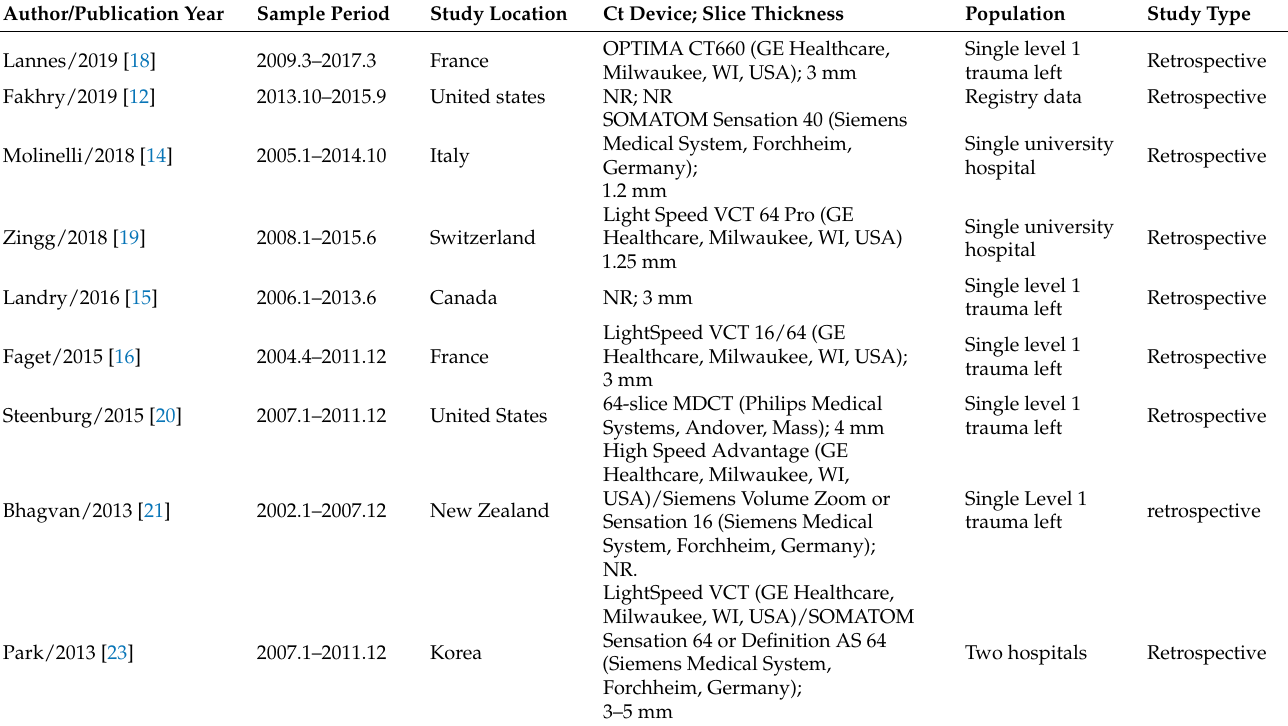
Table 1. Characteristics of the included